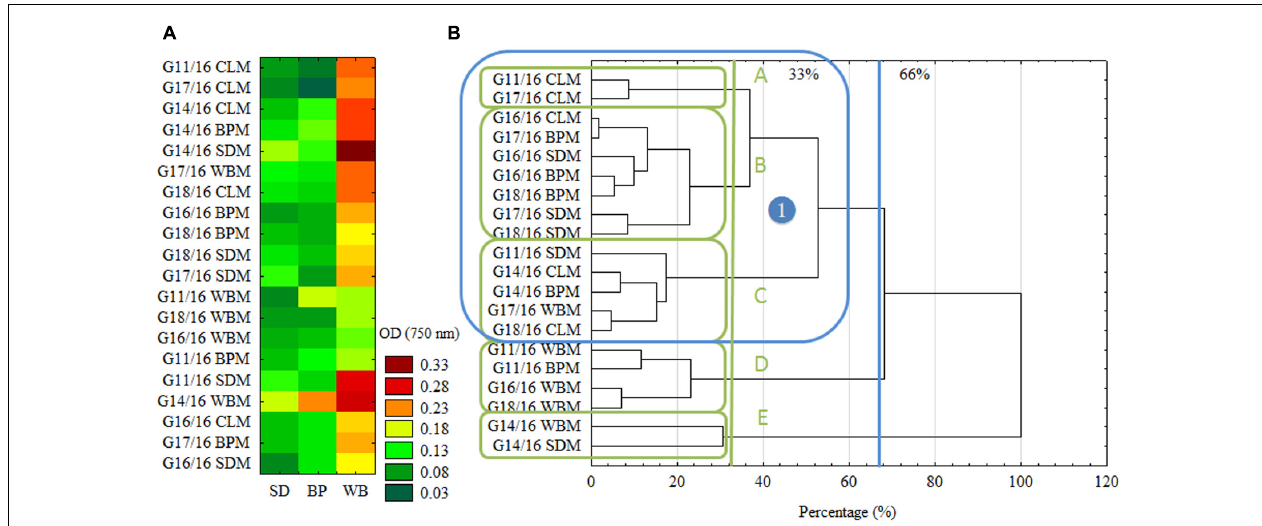
FIGURE 2 | Intraspecific metabolic variability of P. setifera isolates as influenced by preculturing. (A) The cluster analysis depending on the waste-based substrate decomposition in MT2 plate R (cid:13) , (B) clustering according to the stringent Sneath’s criterion (33%) and less restrictive criterion (66%). For explanations: please see Figure 1